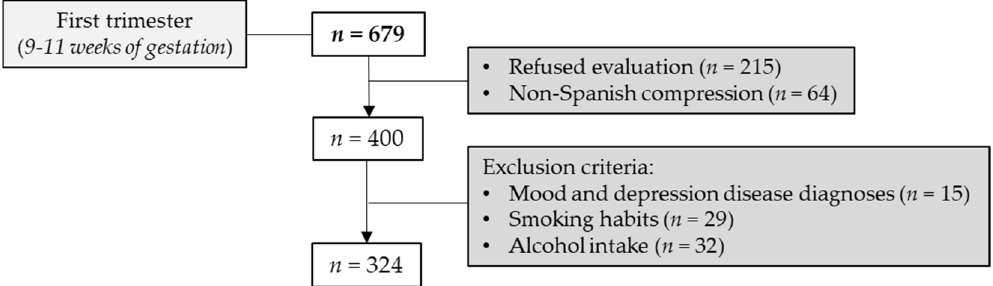
Figure 1. Flow chart of study participants. Sample size ( n ) is shown between brackets. Participants completed a set of questionnaires including sociodemographic and psy- chological variables during the first